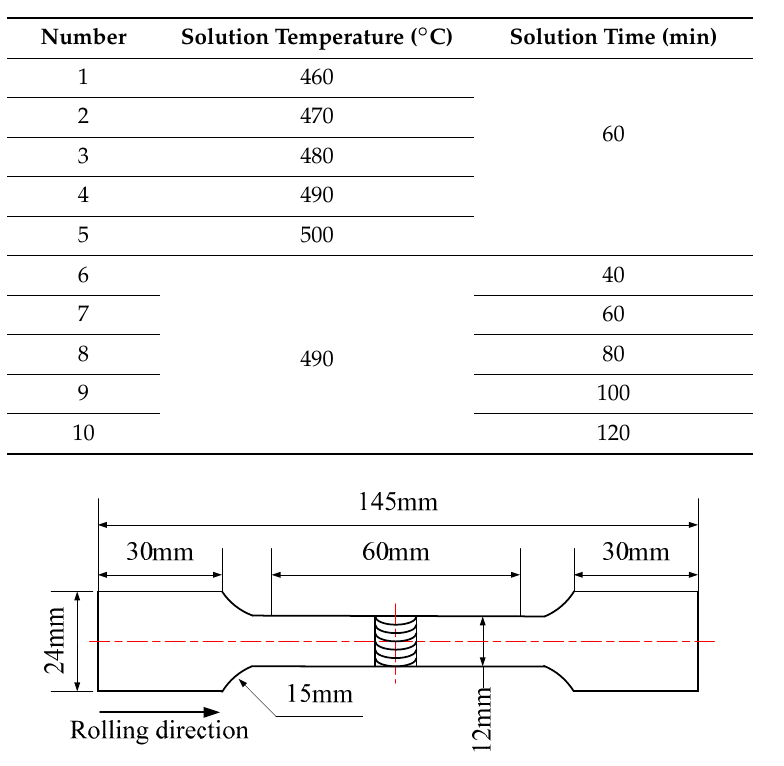
Table 4. Parameters of PWHT.